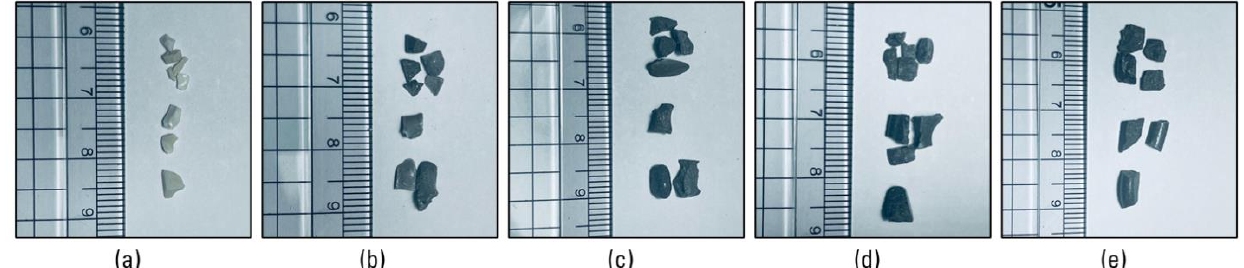
Figure 9. Visual appearance and justification of extruded composite material in granule form: ( a ) RP: extruded and shredded 100% rPET have a pure white colour and a granule size of 1 – 5 mm; ( b ) RPF1: extruded and shredded mixed rPET and fly ash have a light-greyish colour and a granule size of 3 – 7 mm; ( c ) RPF2: extruded and shredded mixed rPET and fly ash have a light-greyish colour a the granule size of 2 – 7 mm; ( d ) RPF3: extruded and shredded mixed rPET and fly ash have a dark-greyish colour and a granule size of 3 – 7 mm; ( e ) RPF4: extruded and shredded mixed rPET and fly ash have a dark-greyish colour and a granule size of 3 – 8 mm.